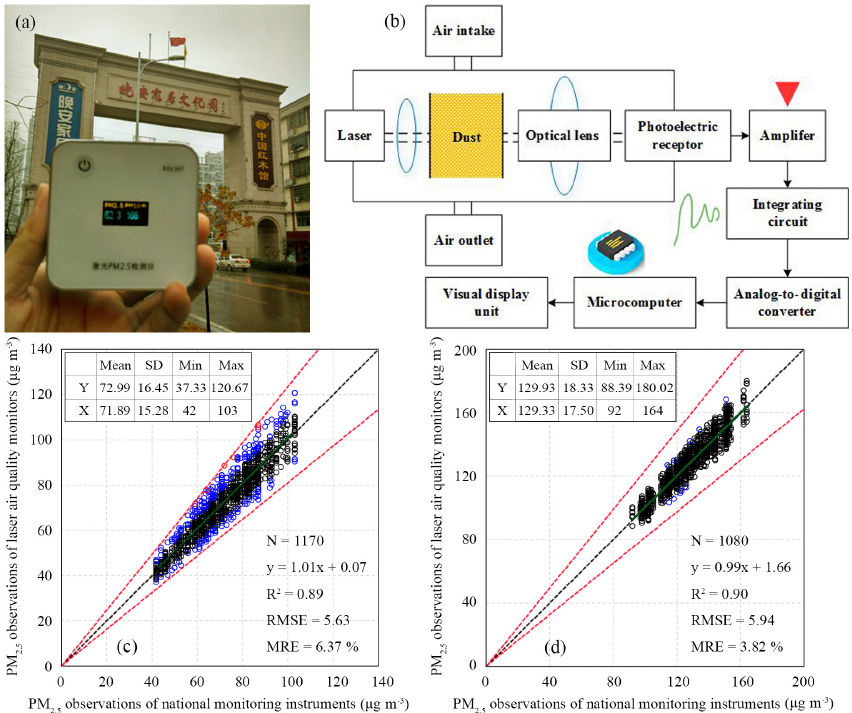
Figure 1. Laser air quality monitor: (a) exterior, (b) measuring principle, and (c, d) scatter plots of hourly PM 2 . 5 concentration from the laser air quality monitor (Y) and national monitoring instrument (X). The black, blue, and red dots indicate PM 2 . 5 observations with a relative error of <10%, 10%–20%, and >20%, respectively. The black and red dotted lines are the 1 : 1 line and 1 : 1 . 2 line as